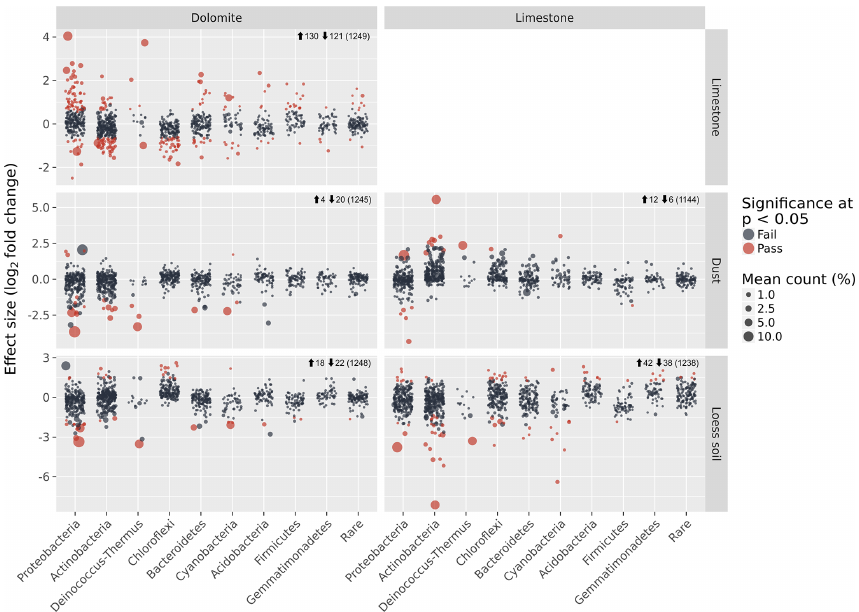
Figure 5. Detection of differentially abundant OTUs between each sample-type pair using ALDEx2. Each circle denotes a single OTU, and its size is its average relative abundance across all samples. The x axis shows the classification of each OTU, whereas the y axis shows the effect size in terms of the log2 fold difference in relative abundance between each sample-type pair. Red circles are OTUs that show significant differential abundance at the P< 0 . 05 level. Numbers next to the arrows indicate the number of significant differentially abundant OTUs that are either more abundant (up arrow) or less abundant (down arrow) in the sample-type appearing in the column compared with the sample-type appearing in the row. Numbers in brackets indicate the total number of OTUs in each pair-wise